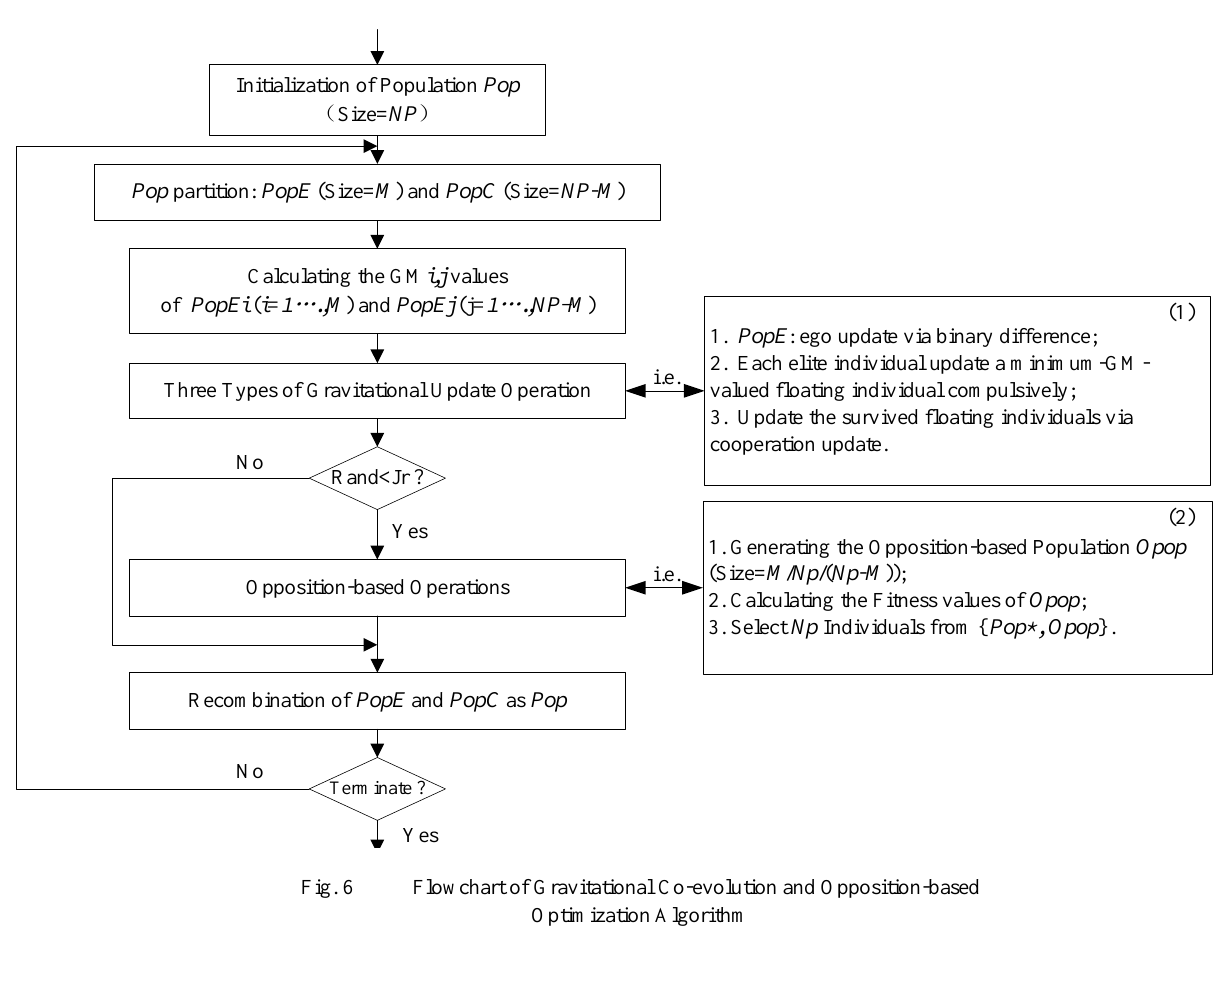
Flowchart of Gravitational Co-evolution and Opposition-based Optimization